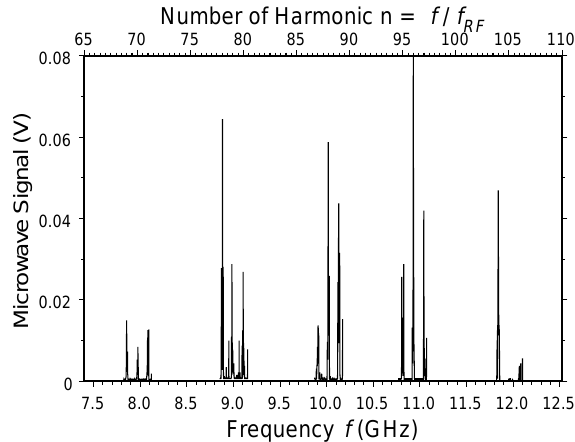
FIG. 5. Heterodyne spectra of the microwave emission from SURF III between 7.8 and 12 GHz. All spectra were recorded at E 0 (cid:1) 255.9 MeV with beam currents between I B (cid:1) 98.7 and 121.0 mA. Not all harmonics were recorded. Each spectrum corresponds to the average of approximately 1000 sweeps of the local microwave oscillator. The oscillator is continuously swept over a 300 MHz interval at a rate of (cid:7) 10 Hz and the resulting spectra are added using a digital oscilloscope. The plot has two x axes: the lower is the frequency of the emitted radiation and the upper is the frequency divided by twice the orbital frequency giving the number of harmonic of the peaks. All spectra were recorded using a preamplifier except for the three peaks at the lowest